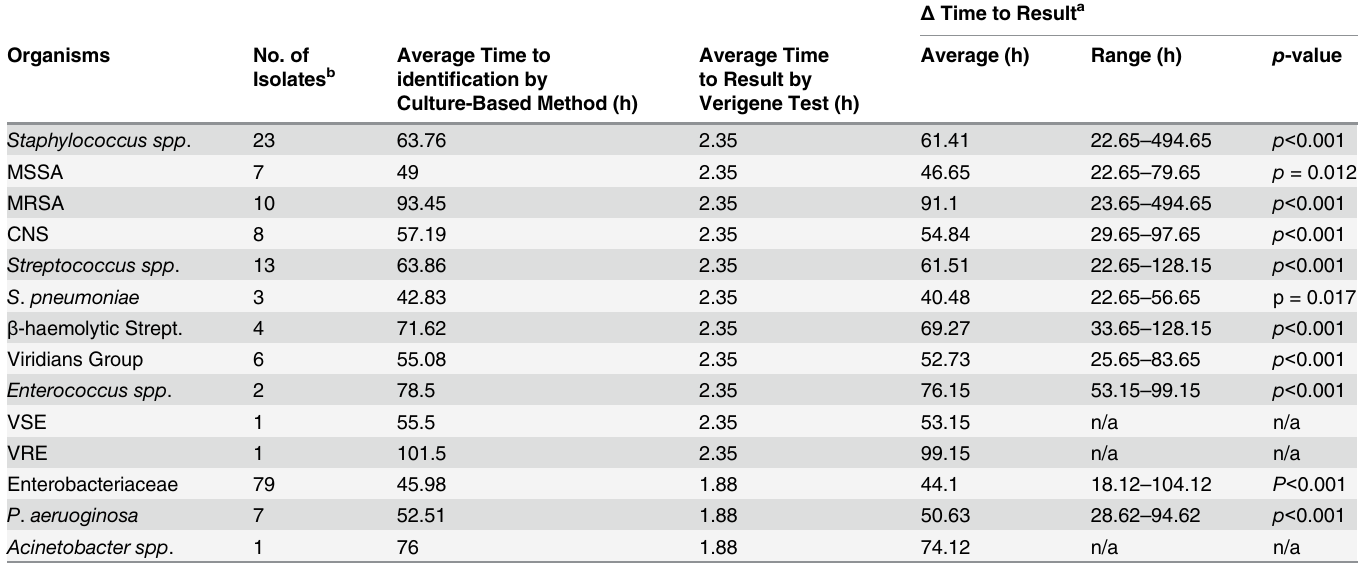
Table 7. Difference in time to result between conventional culture-based method and the Verigene